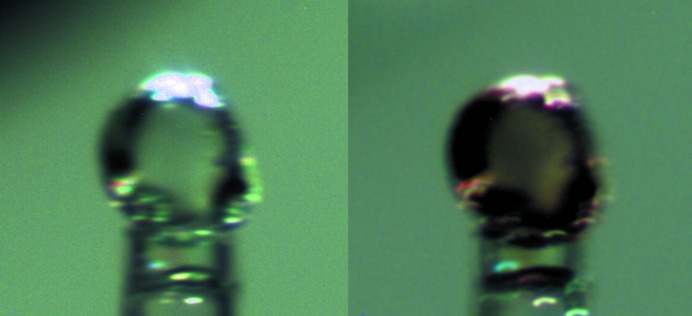
Crystal of [NBnEt3]2[UCl6] before and after 24 h of data collection at 20 K.